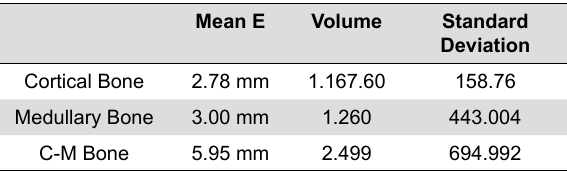
Table 3- Comparison of the cortical, medullary and total (cortical + medullary) bone thickness in the 9 points of the area studied, by gender. The table shows the averages of measurements of the cortical, medullary and total (cortical + medullary) bone thickness according to the gender of individuals